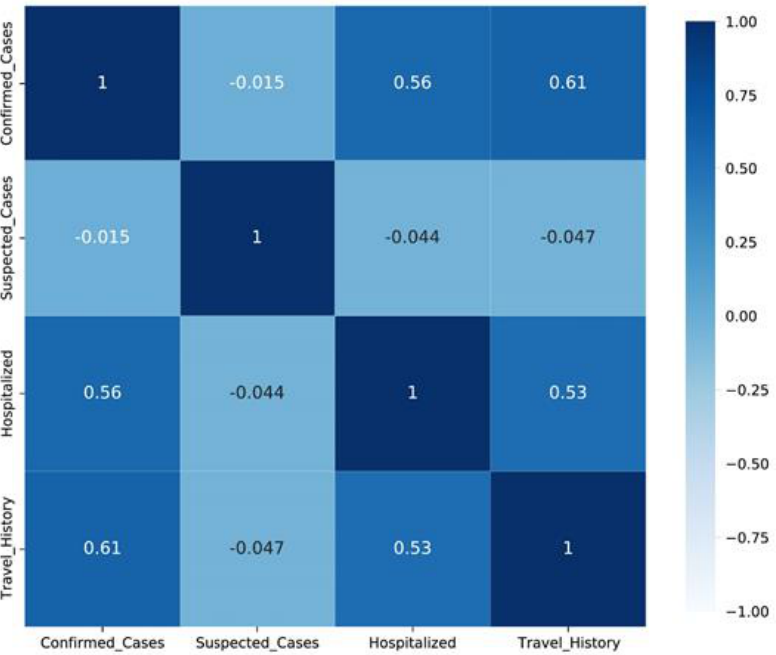
Figure 5. Correlation among confirmed, suspected, and hospitalized cases.